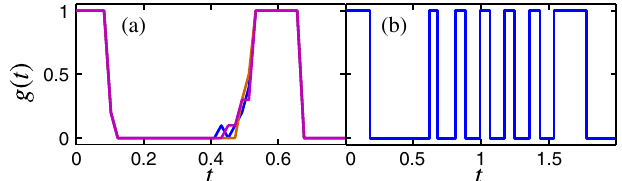
FIG. 2. (a) The optimal protocol obtained from MC simu- lations for a fixed instance of Hamiltonian Eq. (9) with n ¼ 5 spins and total annealing time T ¼ 0 . 8 . Different colors represent different initial protocols. The plots are for S ¼ 40 , but the optimal protocol does not change upon increasing S . (b) A typical protocol obtained for a given instance of Hamiltonian Eq. (9) with n ¼ 5 spins and T ¼ 2 , using a classical optimization solver. We start from a uniform initial protocol with S slices such that δ t ¼ T=S ¼ 0 . 1 .